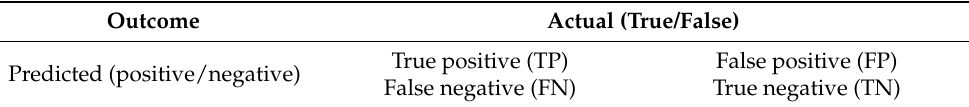
Table 4. Confusion matrix.